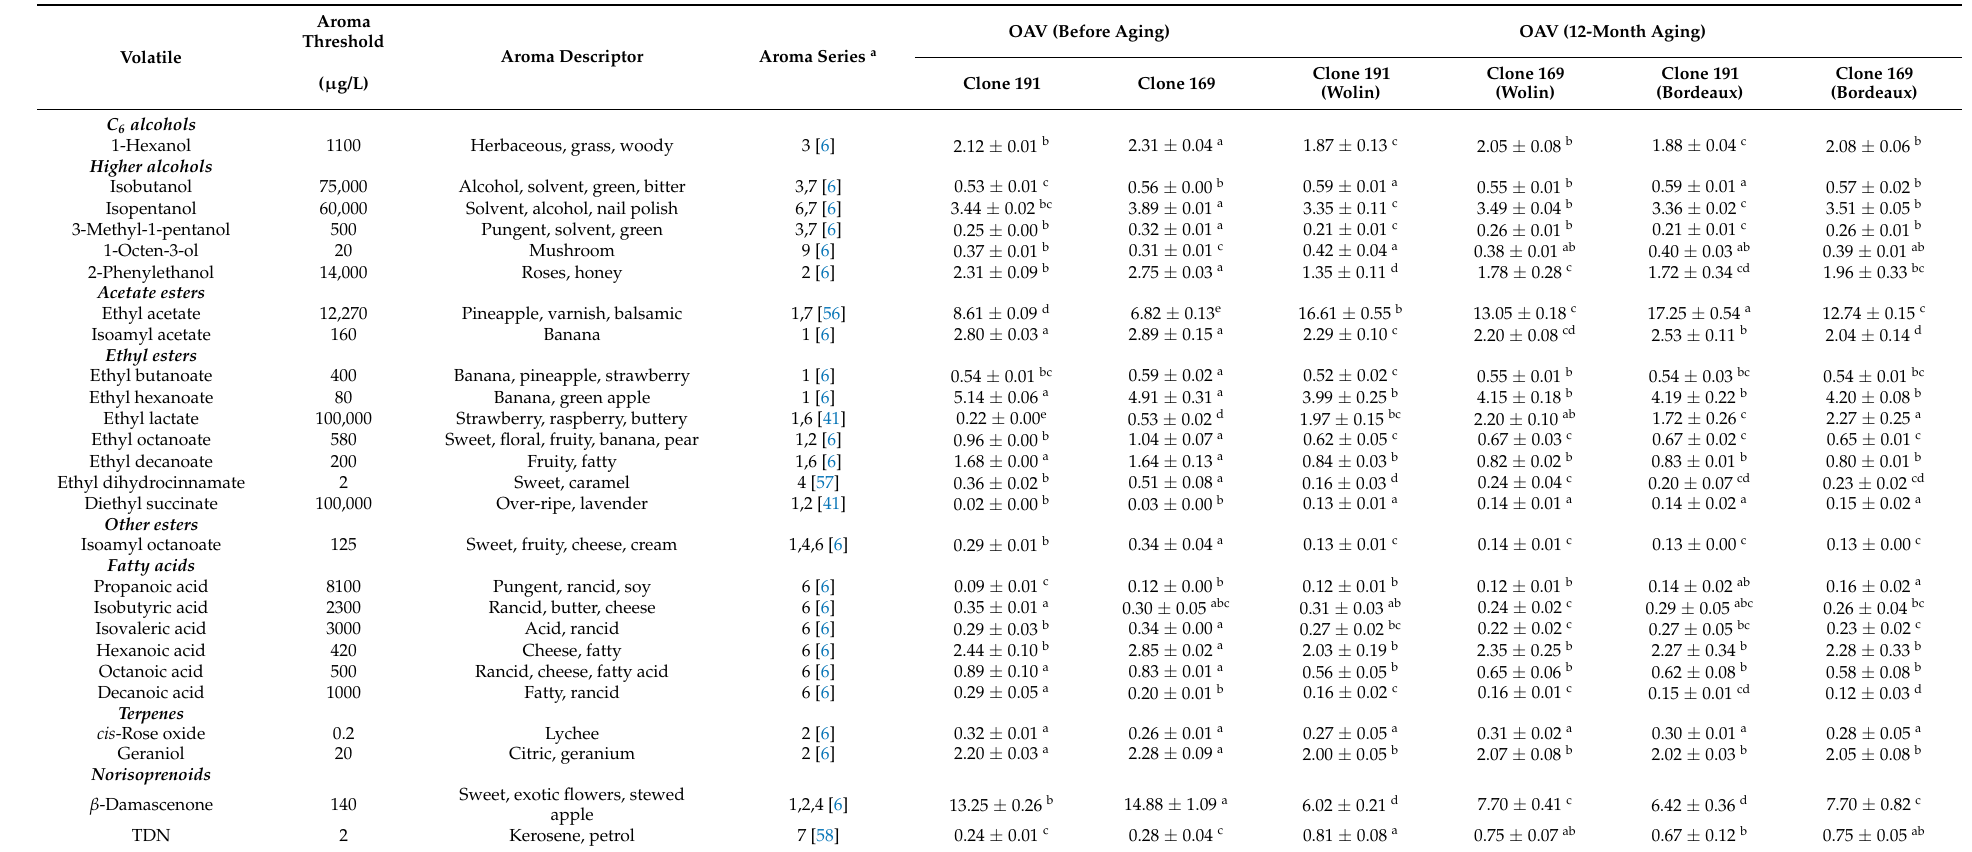
Table 3. Odor activity value (OAV), aroma descriptor, and aroma series of main volatile compounds in wine made of Cabernet Sauvignon clone 169 and 191 before and after 12 months of